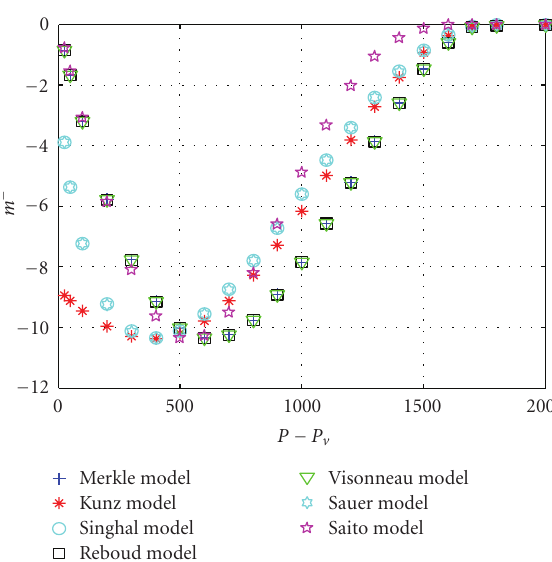
Figure 1: Source terms for the vaporization process.